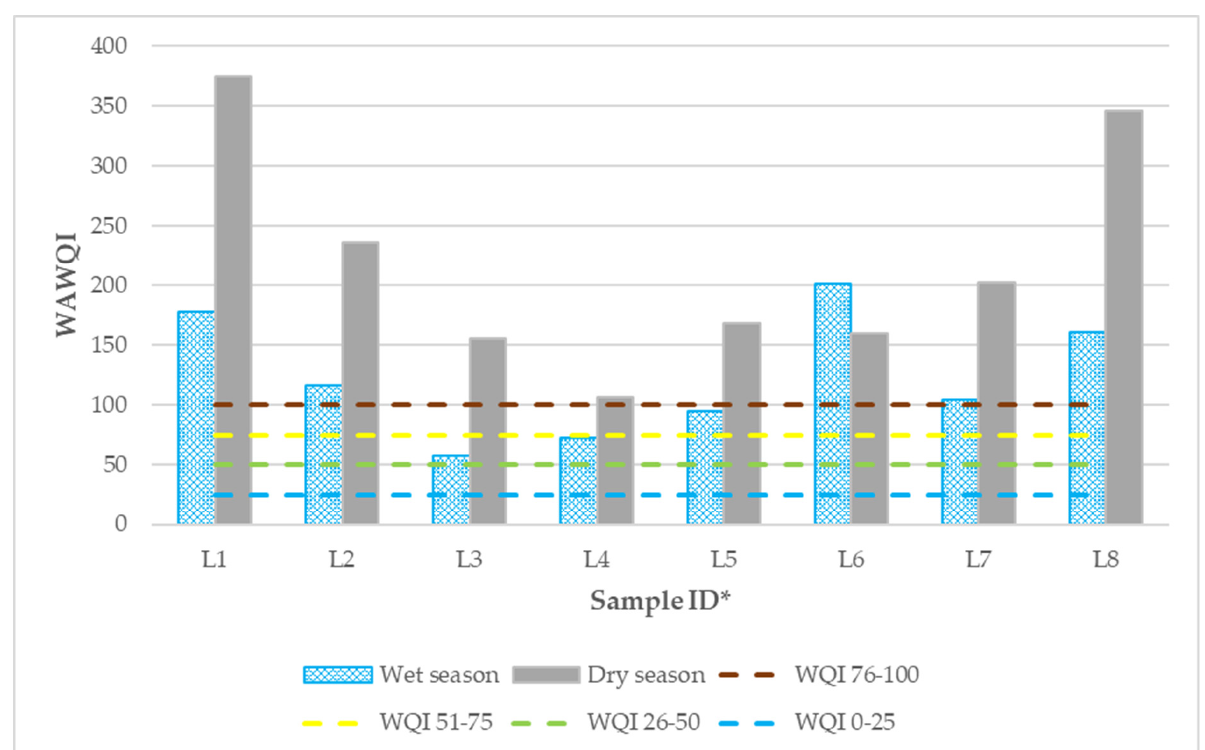
Figure 9. WAWQI in LNHNR by season in 2016. * Sample ID is mentioned in Table 2 with specific Figure 9. WAWQIinLNHNRbyseasonin2016. *SampleIDismentionedinTable2with specific location. Table 6. Calculation of WAWQI for the MXAC in the 2016 Dry